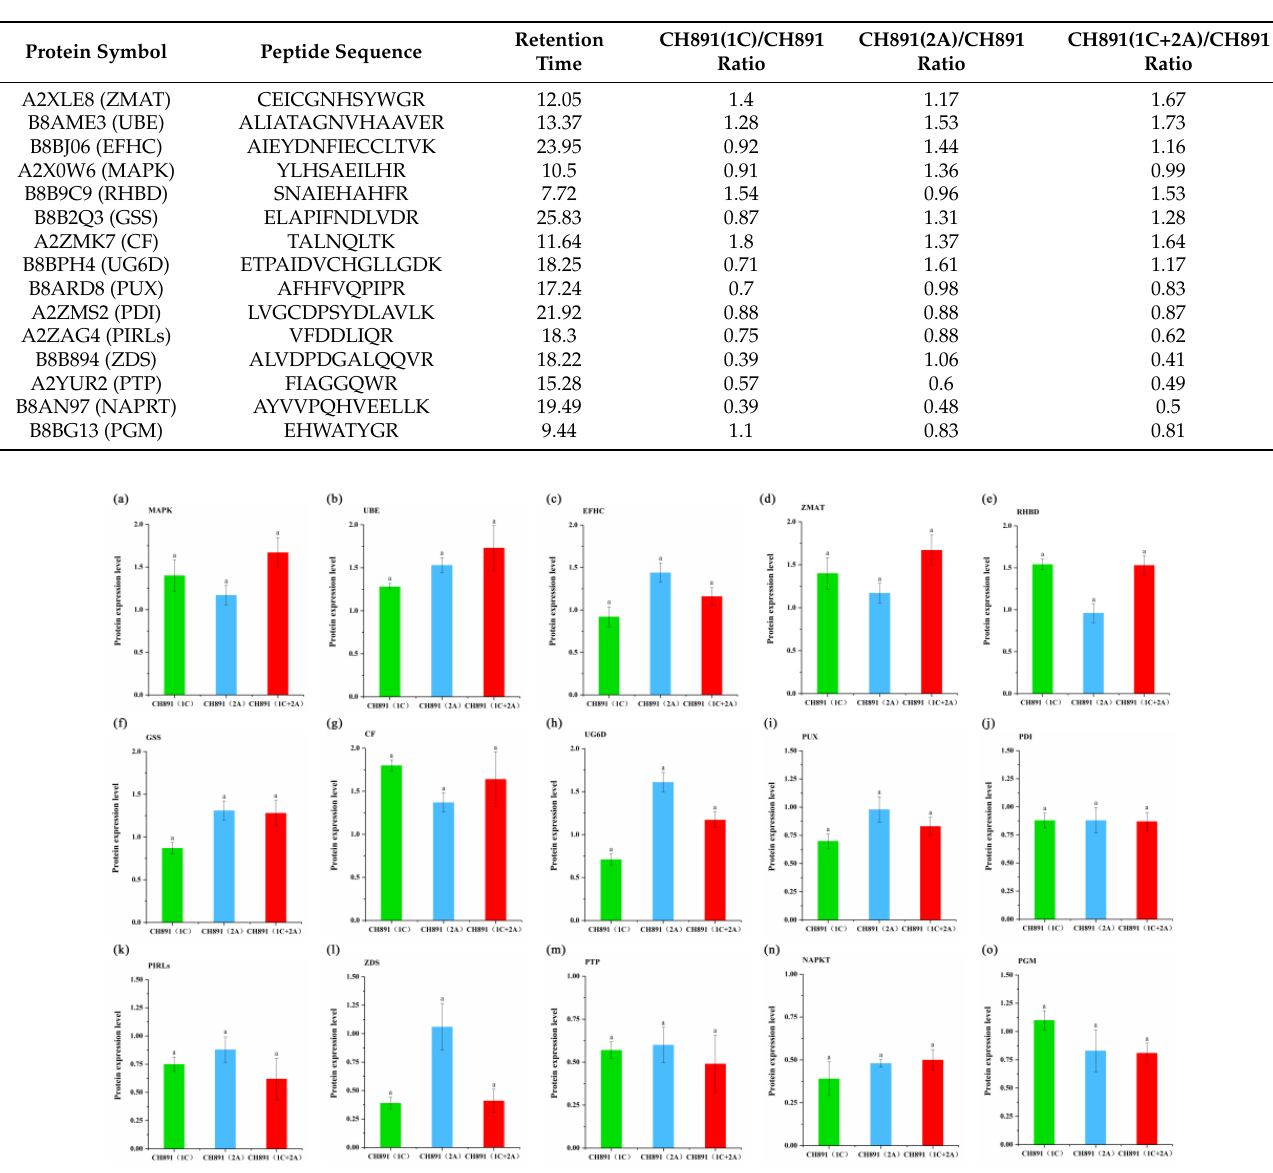
Table 3. Peptide sequences of fifteen candidate proteins in PRM. (Table 3). Compared with the recurrent parents, ZMAT, UBE, EFHC, MAPK, RHBD, GSS, CF, and UG6D were significantly upregulated, and PUX, PDI, PIRL, ZDS, PTP, SHMT, NAPRT, and PGM were significantly lower in the three transgenic lines. On the other hand, except for ZDS, no significant difference was observed in DEPs among the three transgenic lines. The PRM results also correlated well with the proteomics data (Figure 12, Table 3). Therefore, the proteome data were reasonable and reliable.